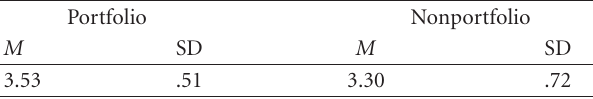
Table 1: Group di ff erences on professionalism.